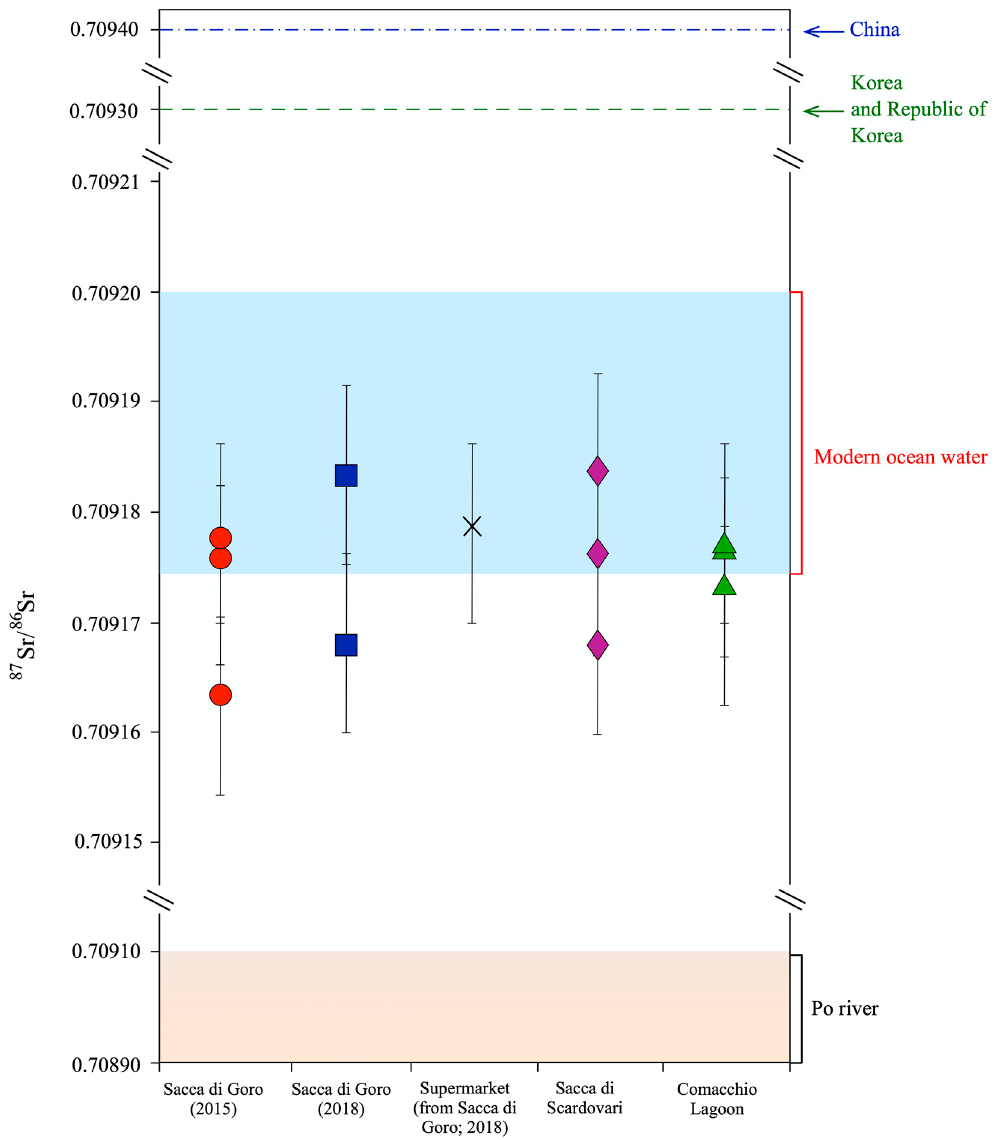
Figure 6. The 87 Sr/ 86 Sr isotopic ratios of shells of manila clams collected on-site from northern Adriatic lagoons and bought at a local supermarket. The isotopic ratios of manila clam tissues from China, Democratic People’s Republic of Korea, and Korea [11], modern ocean water range [68,69,75], and Po River range [66,67] are reported for comparison. The errors bars of the analyses are also